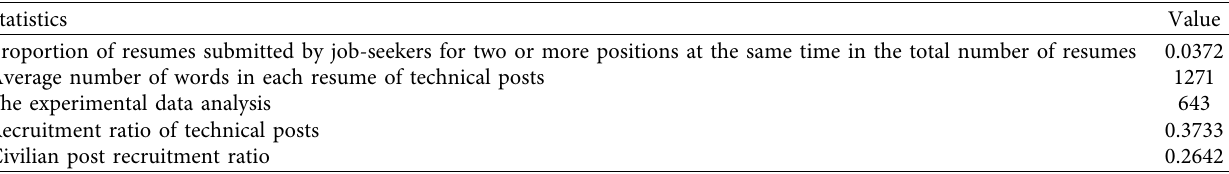
Table 3: Analysis of experimental data.